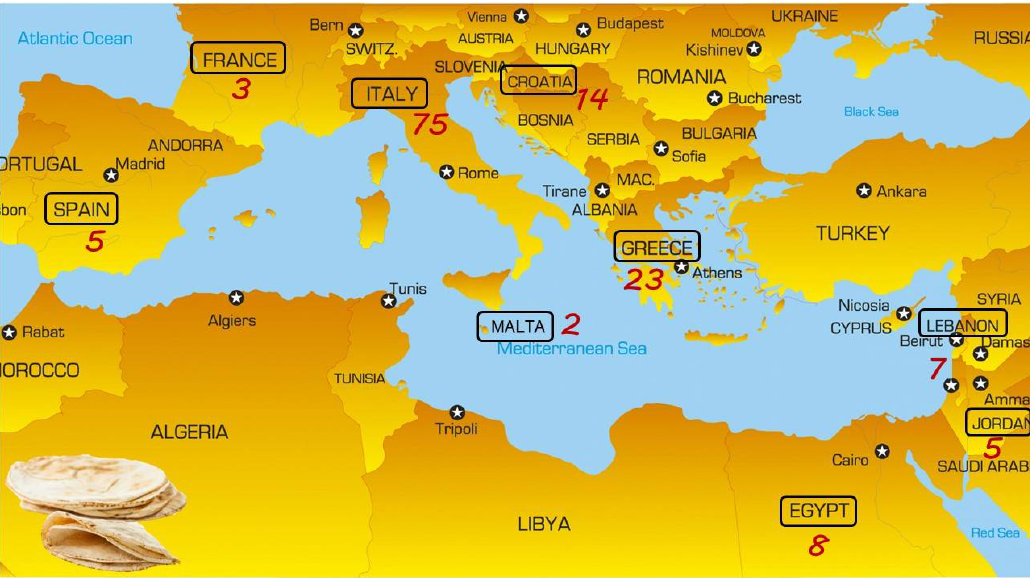
Figure 1. Geographical distribution of flat breads in the surveyed area (Croatia, Egypt, France, Greece, Italy, Jordan, Lebanon, Malta, and Spain).